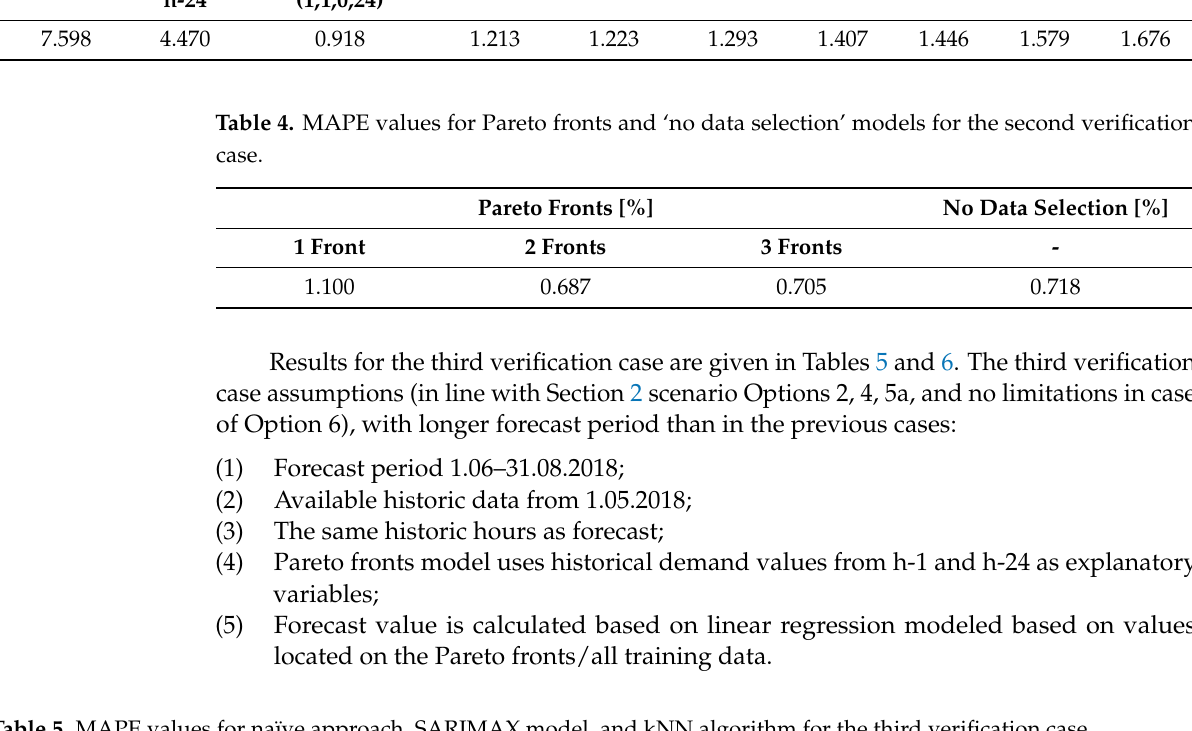
Table 5. MAPE values for naïve approach, SARIMAX model, and kNN algorithm for the third verification case. Naïve Approach [%]